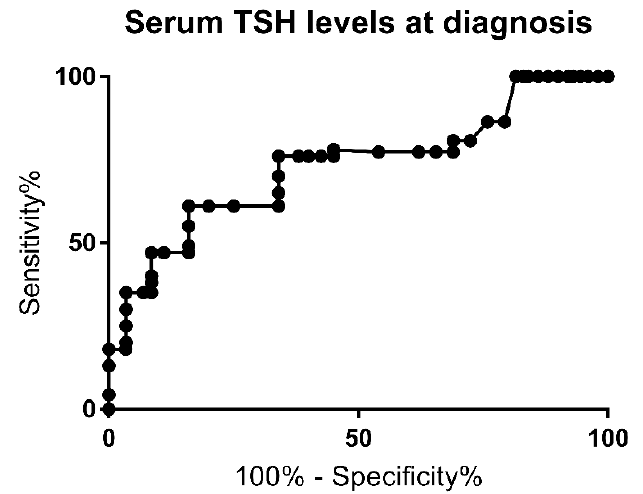
Figure 1. Receiver Operating Curve (ROC) for serum TSH level at the time of diagnosis.